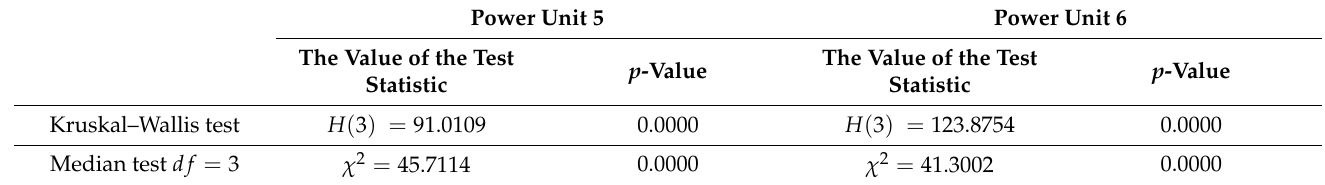
Table 3. Test results for the variable cooling efficiency– ε